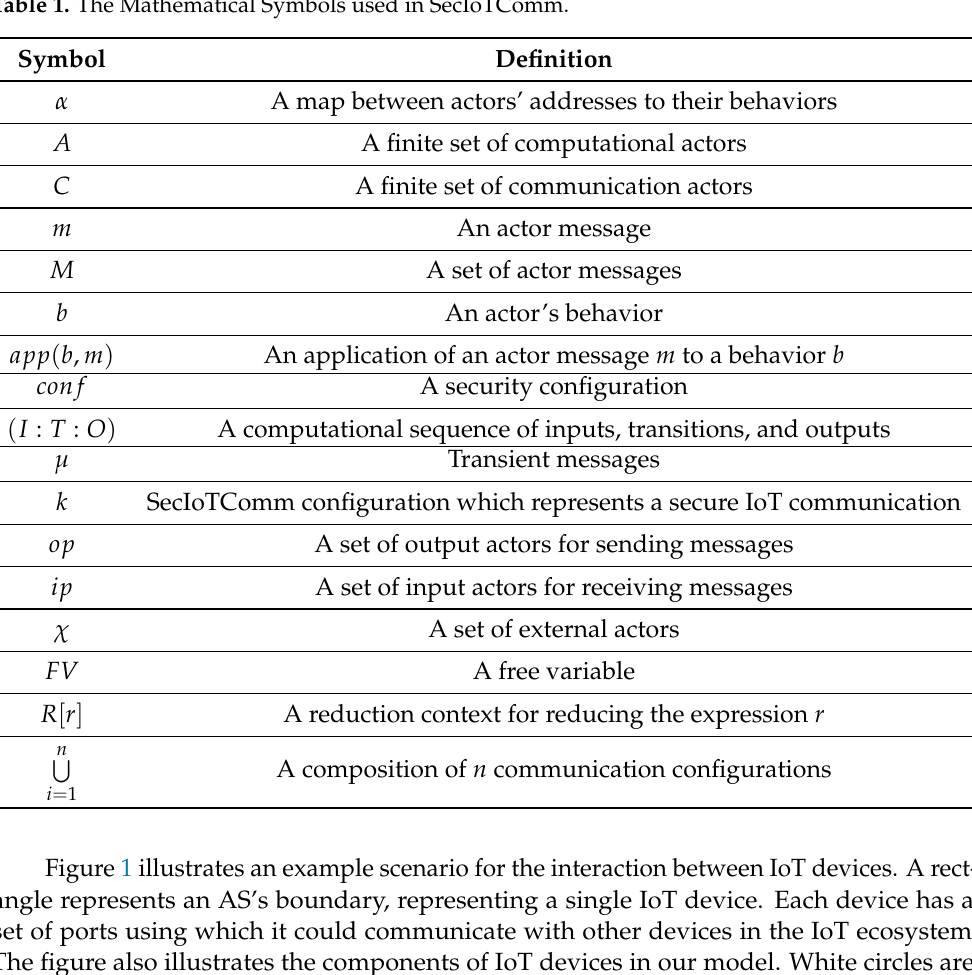
Table 1. The Mathematical Symbols used in SecIoTComm.